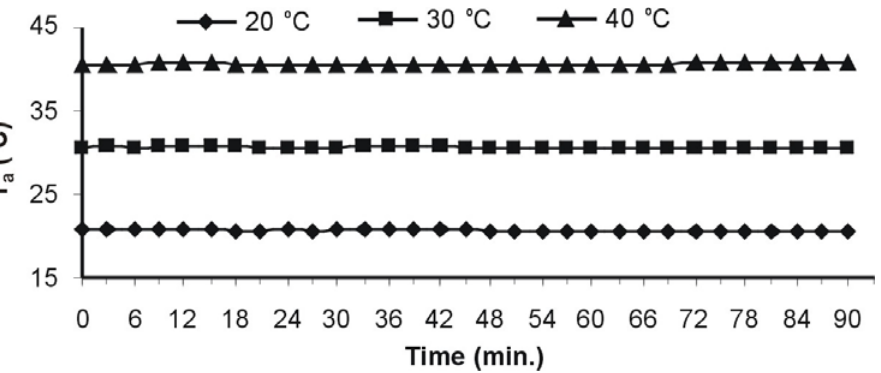
Figure 5. The variation of the waste water temperature for the circulation pump flow rate CP I during the experiment